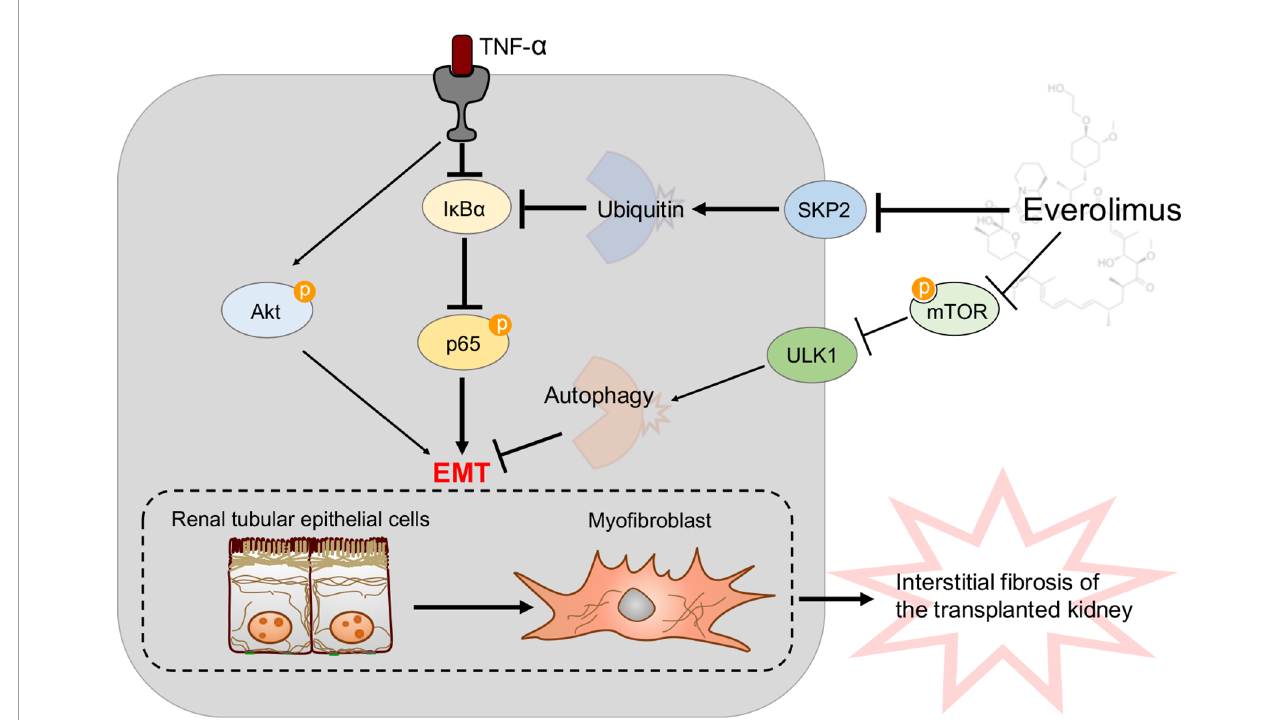
FIGURE 9 | A model is proposed to illustrate the protective mechanisms of EVR on the pathogenesis of transplanted renal tubular EMT and interstitial fi brosis in CAD. TNF- a could induce renal tubular EMT and then promote transplanted renal interstitial fi brosis through Akt and NF- k B signaling pathway activation in CAD recipients. Of these, NF- k B signaling pathway activation was due to I k B- a decrease and p-p65 increase. On the one hand, EVR could inhibit progression of renal tubular EMT via blocking the mTOR/ULK1 pathway to activate autophagy fl ux directly. On the other hand, EVR could also affect Skp2 (a E3 ubiquitin ligase) activity and inhibit I k B- a ubiquitin degradation, and thus restrain progression of renal tubular EMT through impacting NF- k B pathway activation. Red arrows represent the effect of TNF- a and dark blue arrows represent the effect of